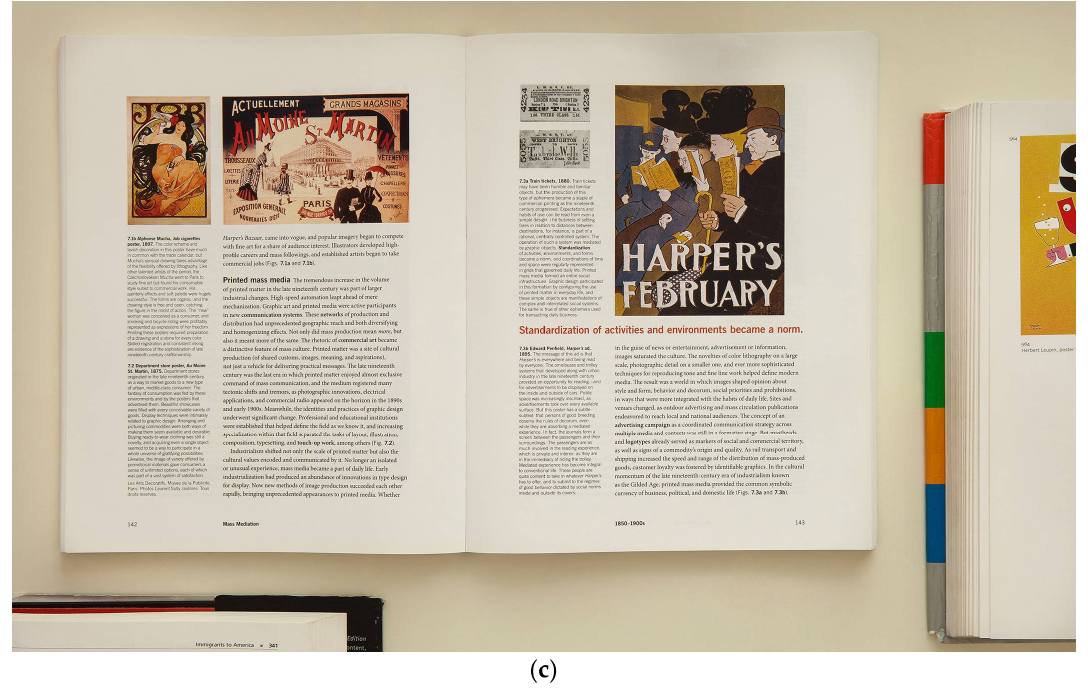
Figure 1. ( a ) Richard Hollis, Graphic Design. A concise history , 1994. The items, a selection of Dutch designs from the Twenties and Thirties, are shown in black and white in thumbnail size. The stamps (bottom right) are reproduced at a slightly smaller dimension, maybe in an attempt to suggest the difference in size. Captions are short and provide no comment [7]. Note: All the selected books have been photographed next to each other in the attempt to keep a sense of scale between them. The selected spreads are not meant to represent the books in their entirety, but to show some of the ways images are used in books. Photos by Vanja Macovaz; ( b ) Robin Kinross, Modern typography. An essay in critical history , second edition, 2004. In the “Examples” section, text and images are rotated 90 degrees to better accommodate the items, which are mostly book covers and spreads; a real-size detail of a page is provided [8]; ( c ) Johanna Drucker & Emily McVarish, Graphic Design History. A